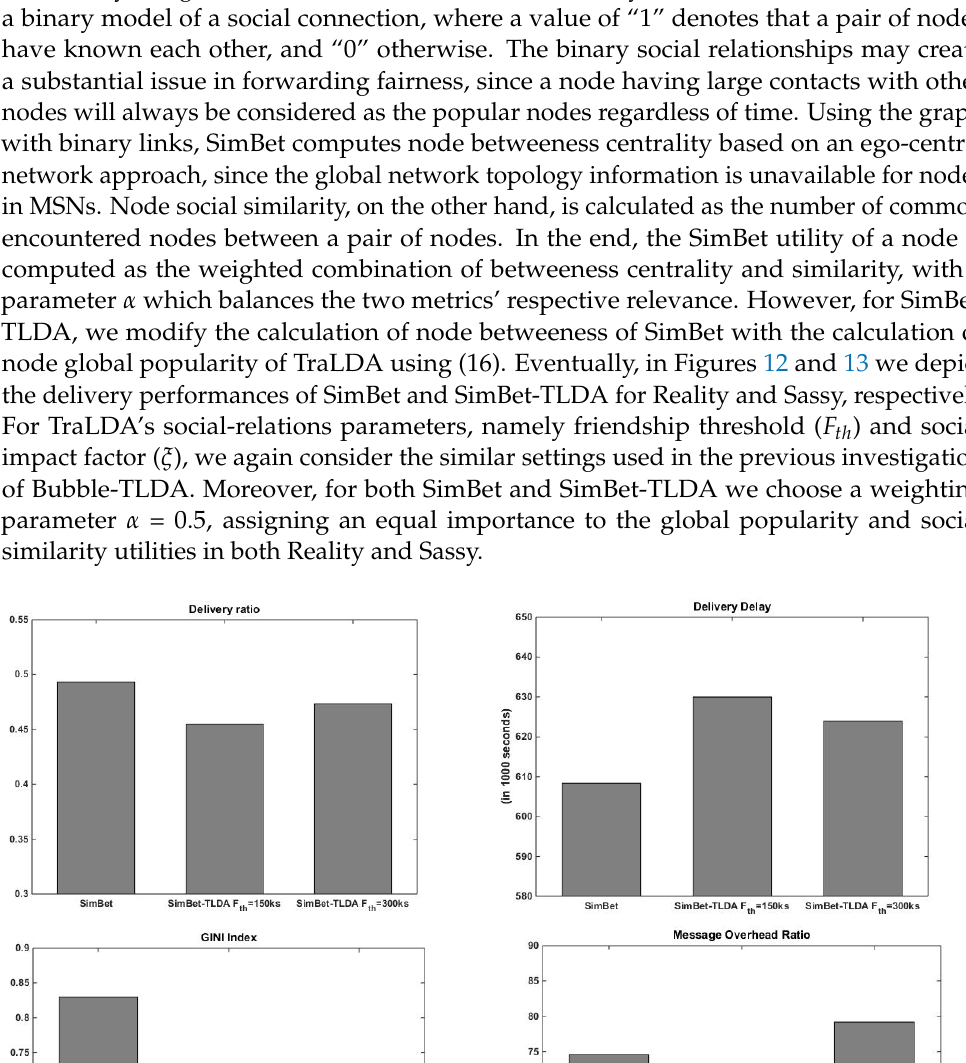
19 of 23 Figure 11. ( left ) Social impact factor ( 𝜉 ) vs. GINI index, and ( right ) social impact factor ( 𝜉 ) vs. delivery latency of Bubble-TLDA for Reality ( 𝐹 (cid:3047)(cid:3035) = 150 ks) and Sassy ( 𝐹 (cid:3047)(cid:3035) = 2 ks). A social impact factor represents the contribution of neighbours’ influence on the node popularity. A higher 𝜉